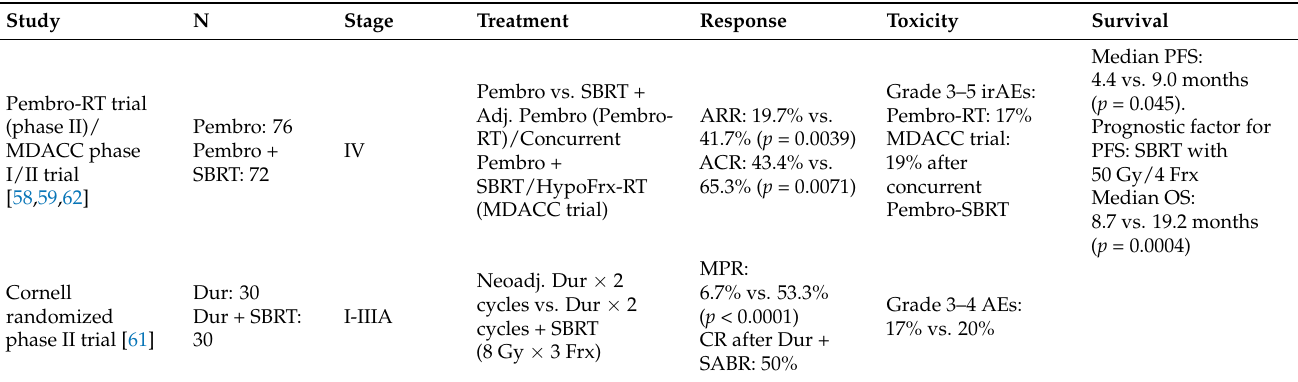
Table 4. Emerging clinical evidence supporting combining SBRT with ICIs in high-risk N0 ES NSCLC.